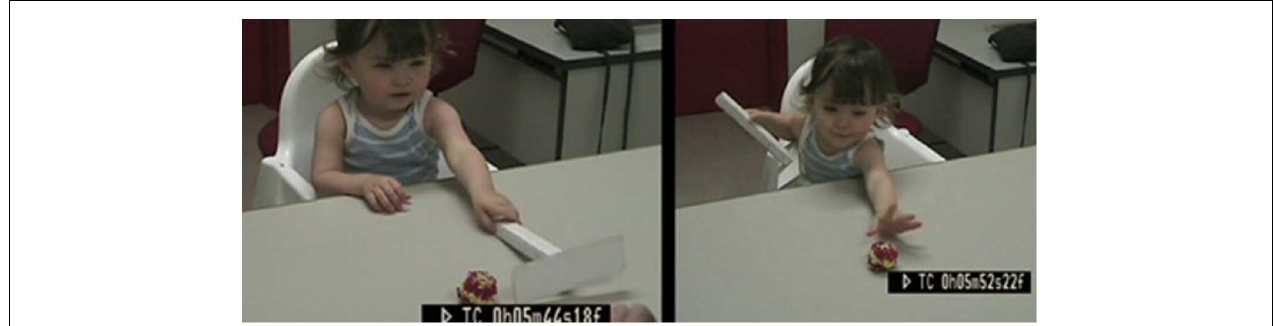
FIGURE 1 | Typical spontaneous behavior of a 16-month-old when an out-of-reach toy is presented to the side of a rake (spatial gap): the child grasps the rake, discards it, and begs for the toy.